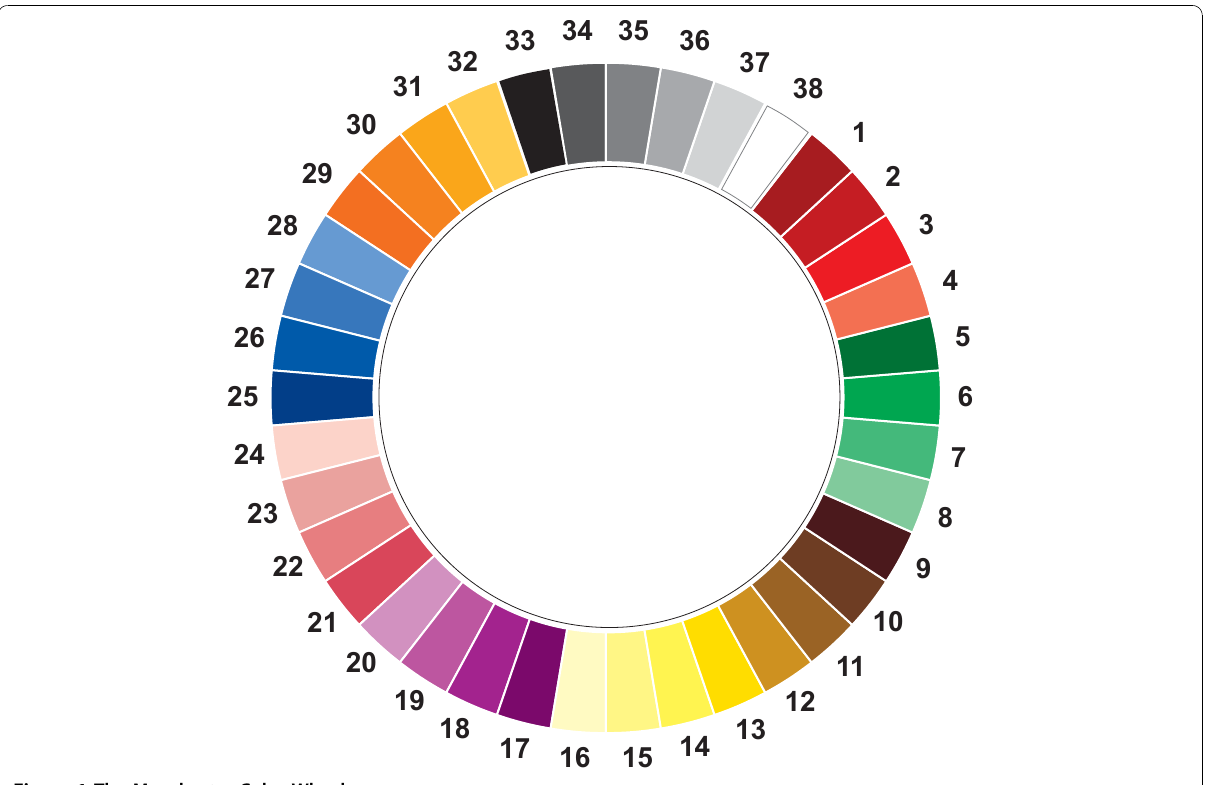
Figure 1 The Manchester Color Wheel